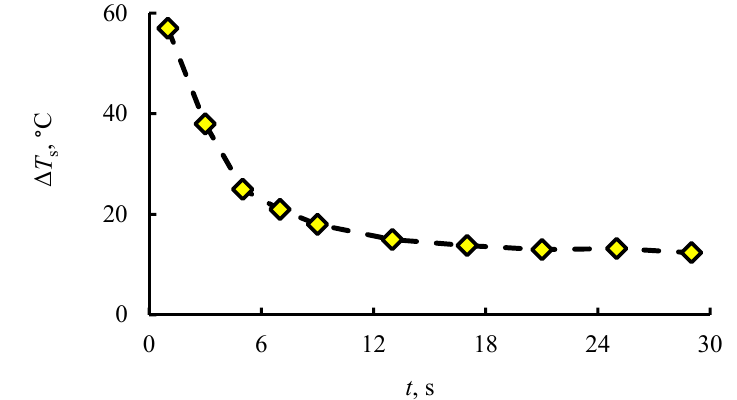
Figure 3. Changes of average temperature for the entire surface of drop 2 over time.